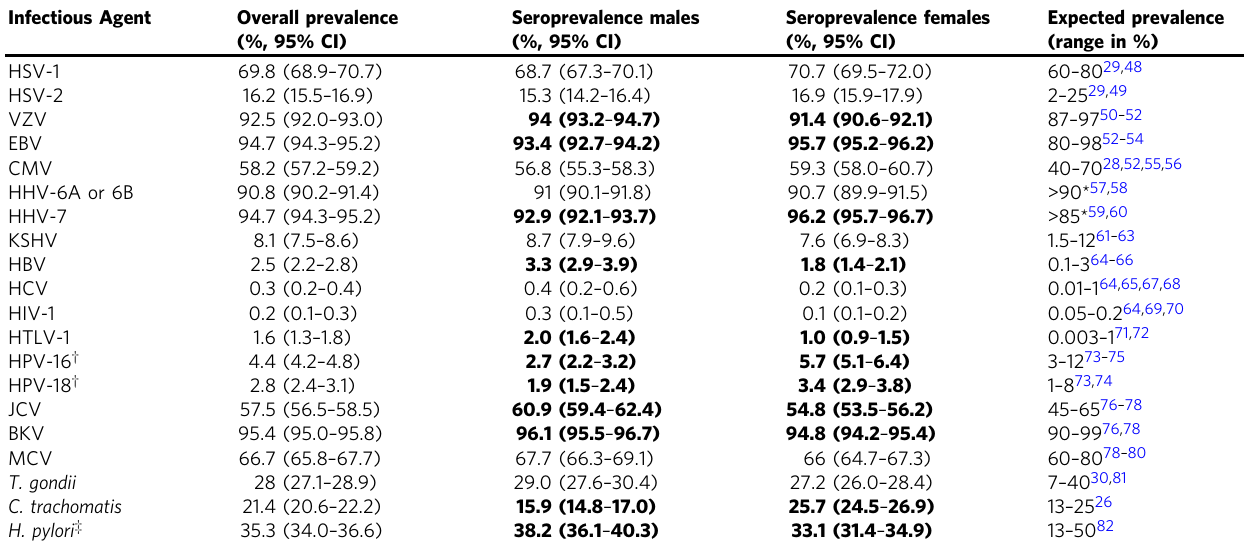
Table 2 Unadjusted seroprevalence estimates and 95% con fi dence intervals for infectious agents tested using the Multiplex Serology platform in all 9695 individuals, overall and strati fi ed by sex. Infectious Agent Overall prevalence (%, 95%